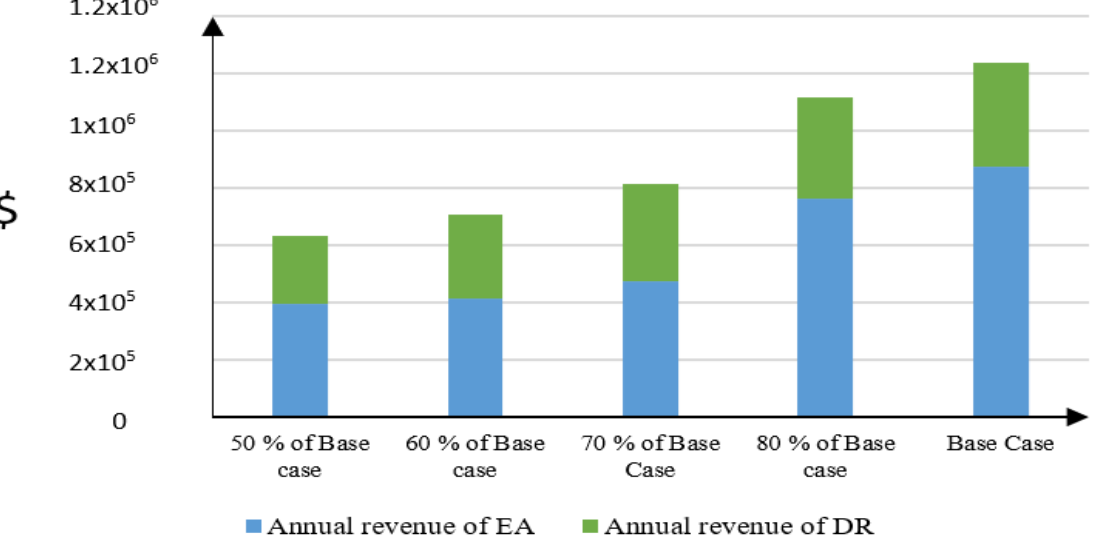
Figure 10. Results of available purchasing budget sensitivity case study in terms of the revenue components.